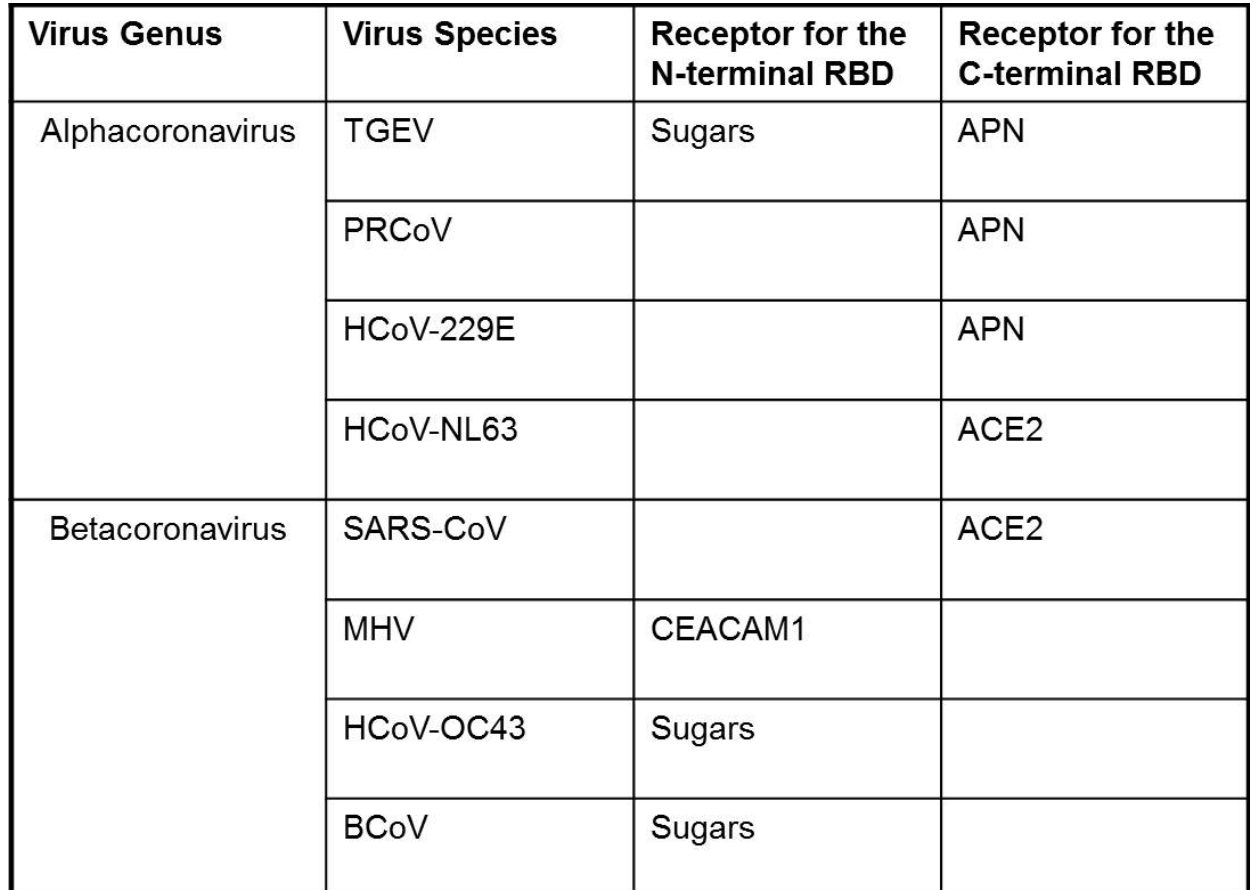
Table 1. Coronaviruses and their receptors. Viruses include TGEV: Transmissible Gastroenteritis Virus, PRCoV: Porcine Respiratory Coronavirus, HCoV-229E: